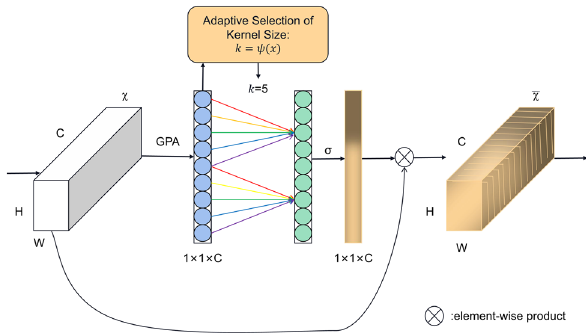
Fig. 3 Diagram of this efficient channel attention module. Given the aggregated features obtained by global average pooling (GAP), ECA generates channel weights by performing a fast 1D convolution of size k, where k is adaptively determined via a mapping of channel dimension